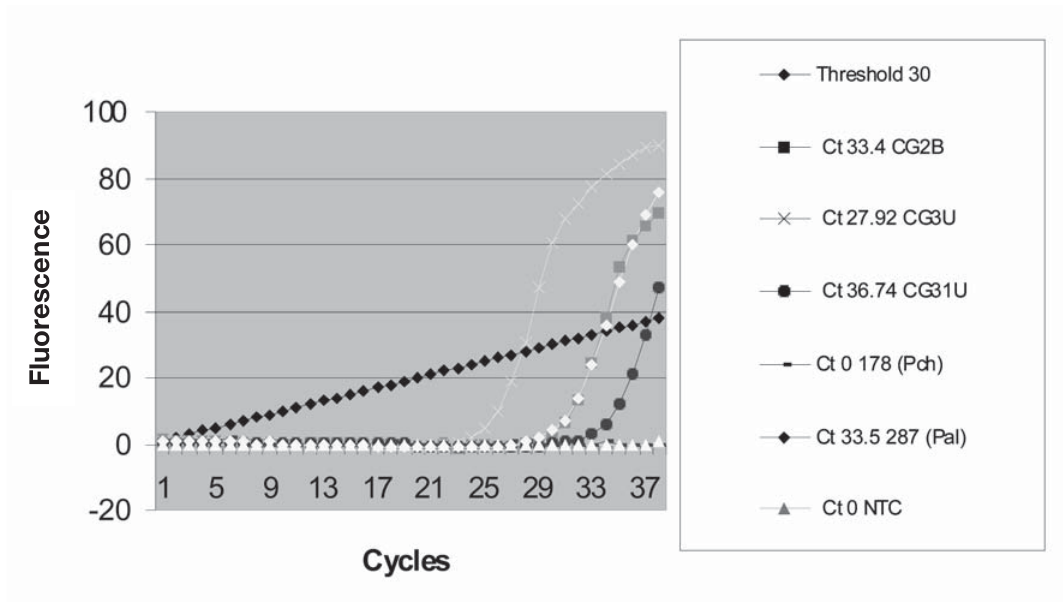
Fig. 5. Real-time PCR run data from trunk cross-sections from which Phaeoacremonium aleophilum (Pal) had pre- viously been isolated. Cycle threshold (Ct) scores were recorded when fluorescence values crossed an original threshold set at 30 florescence units. Cycle threshold (Ct) scores were consistent with the positive Pal